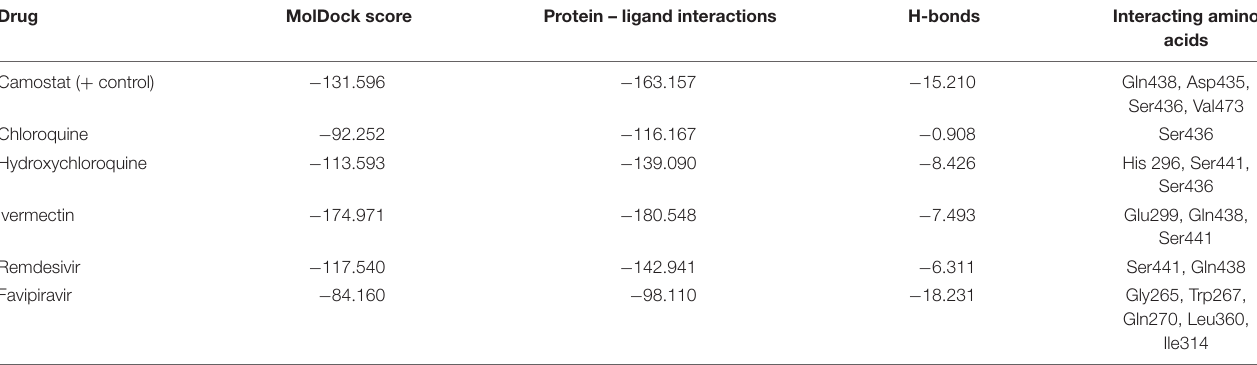
TABLE 6 | Docking scores and functions of drugs against human TMPRSS2 protein. Drug MolDock score Protein – ligand